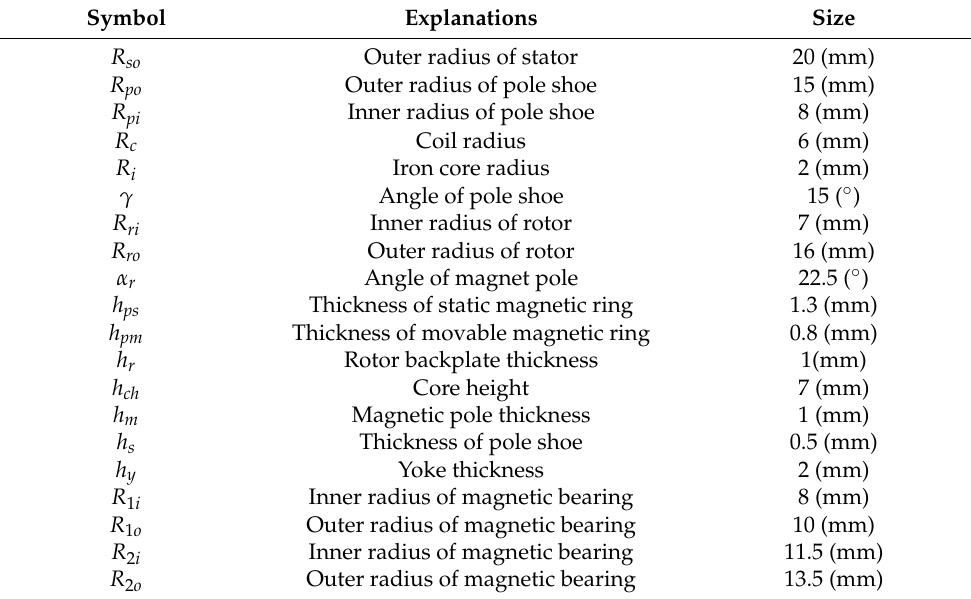
Table 1. Specifications of the magnetic suspension system.